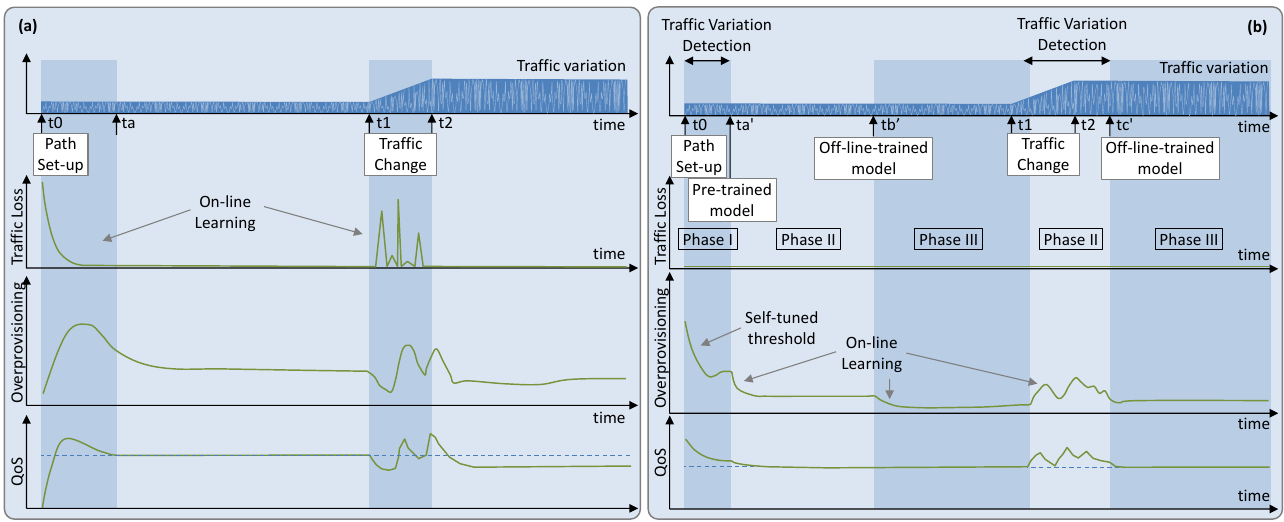
Figure 2. Operation lifecycle. ( a ) Online learning RL operation. ( b ) Offline training with online fine tuning RL operation.